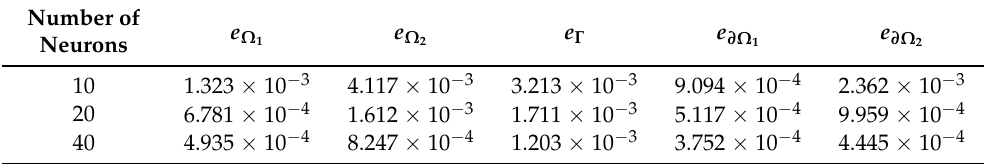
Table 10. Comparison of errors in different terms with different numbers of neurons for Example 5. Number